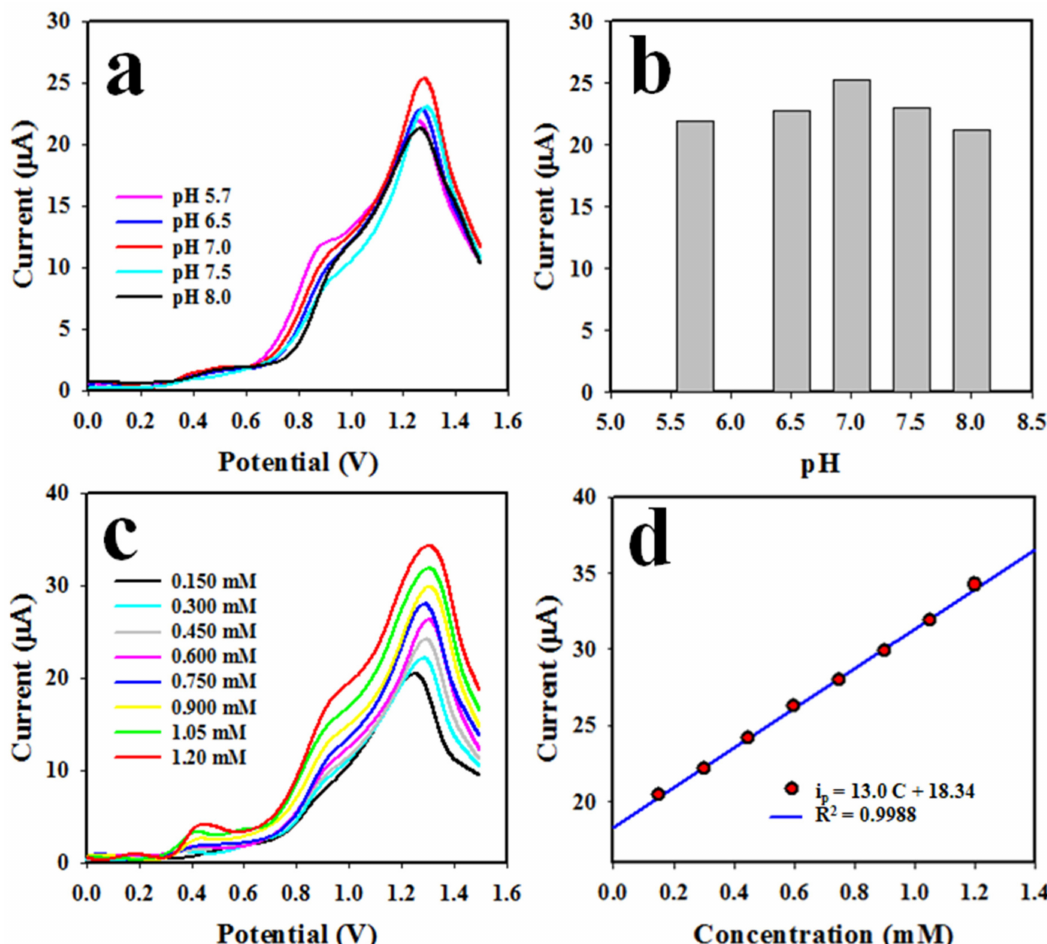
Figure 7. ( a ) The effects of pH on the DPV analysis of TU, ( b ) the bar diagram of the effects of pH in the electrochemical analysis of TU, ( c ) the DPV analysis of TU at pH 7.0 using a low-to-high concentration range and ( d ) TU sensor